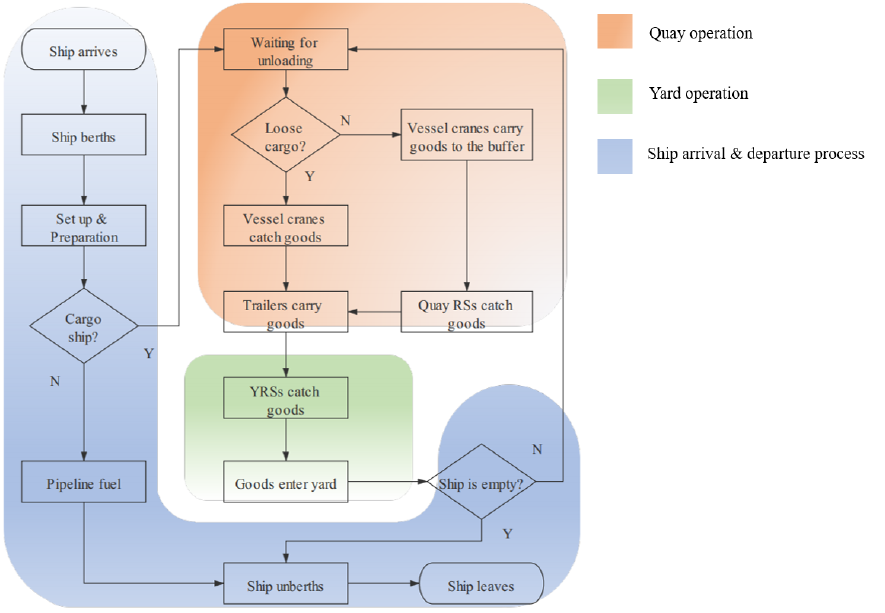
Figure 4. Simulation